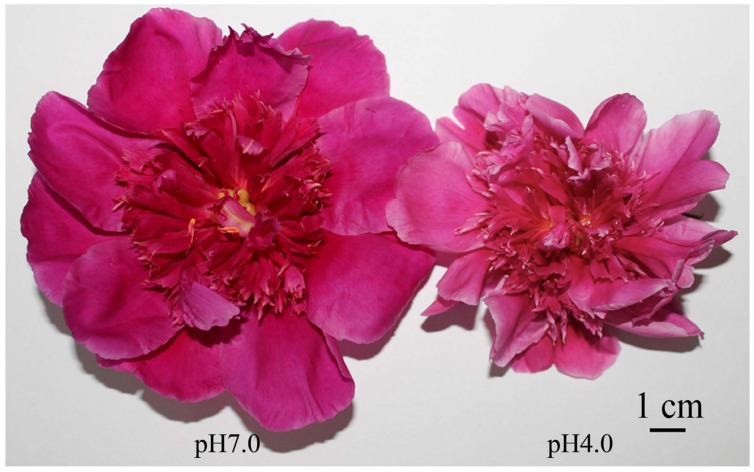
Herbaceous peony flowers in the blooming stage at pH 7.0 and 4.0 (Zhao et al., 2013).